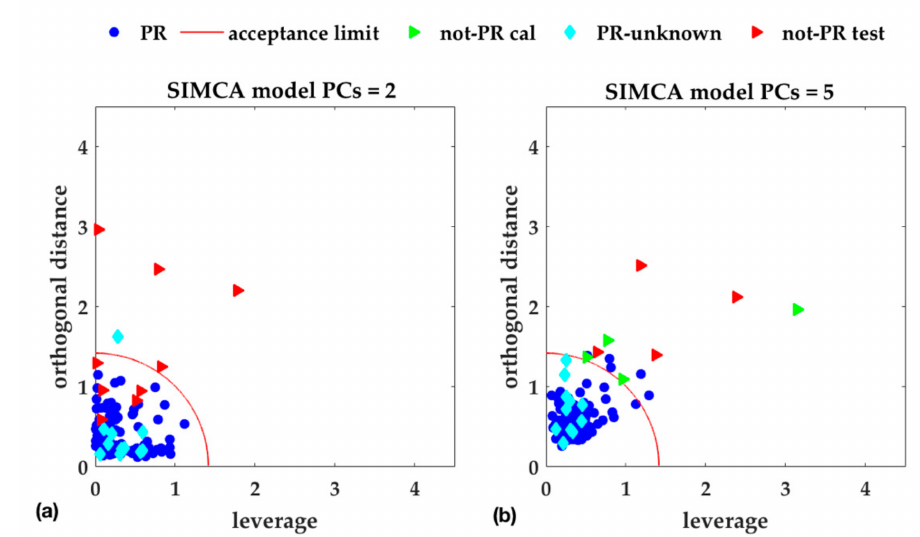
Figure 4. Reduced score distance ( T 2 / T 2 lim ) vs. reduced orthogonal distance ( Q / Q lim ), at 95% confidence level. ( a )One-classSIMCAmodelwithtwocomponents, selected accordingtomaximumSensitivity_CV; ( b ) One-class SIMCA model with five components, selected according to maximum E ffi ciency_CV (or selected according to minimum RMSECV, i.e., the model is the same). E ffi ciency_CV has been estimated by the not-PR cal. samples (green triangles). The red circle (radius = 1.414) corresponds